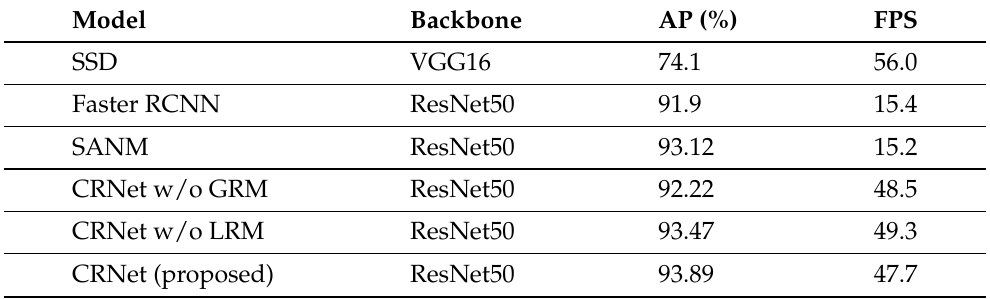
Table 6. The results of running time